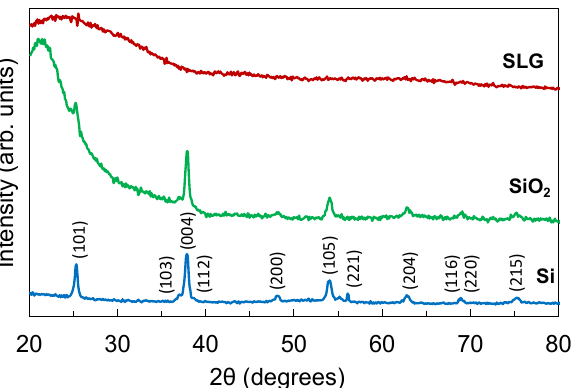
Figure 1. GIXRD spectra of TiO 2 films deposited on Si, SiO 2 , and SLG substrates with a film thickness of 80 nm.